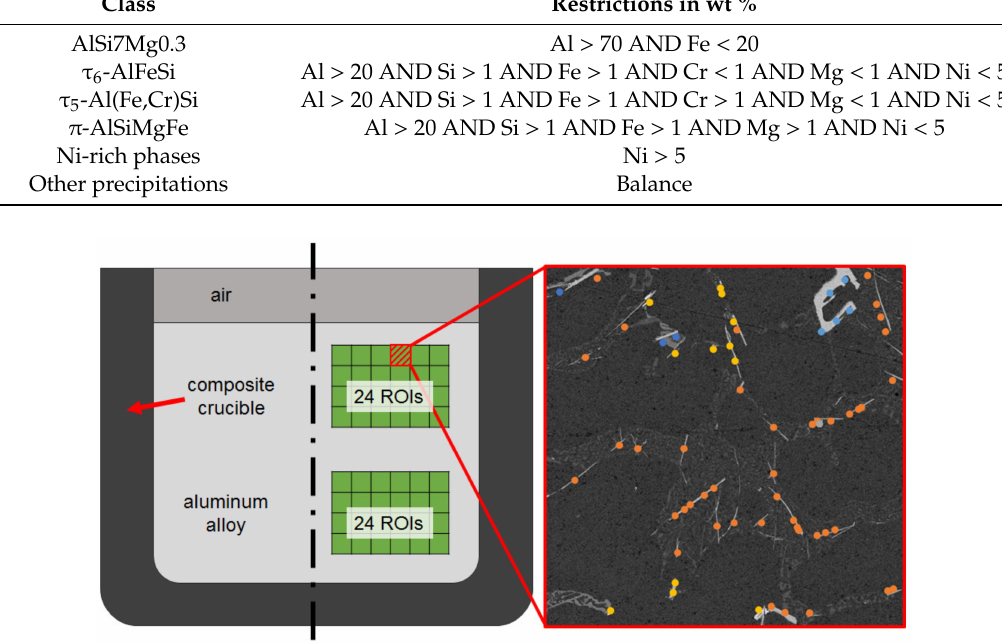
Figure 3. Schematic layout of regions of interest (ROIs) analyzed with ASPEX PSEM / AFA ( left ), with exemplary classification of detected precipitations within the solidified aluminum alloy ( right